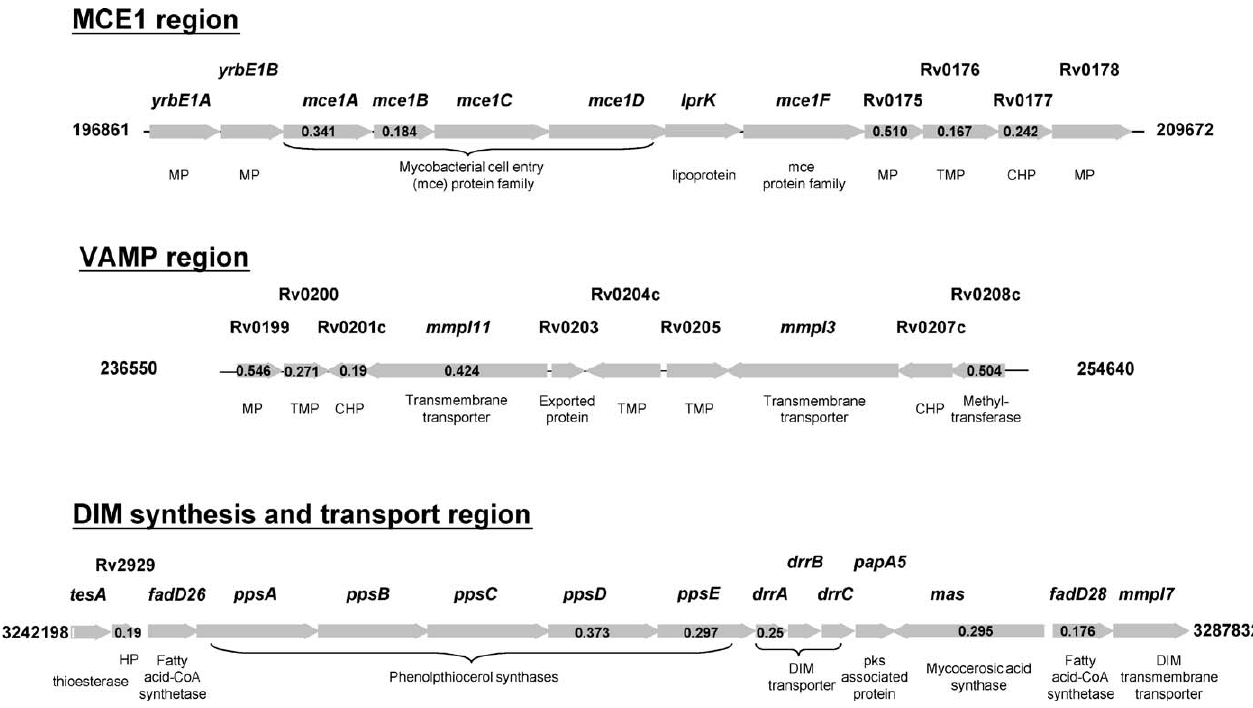
Figure 2. Gene Regions with Low Intracellular Fitness Ratios The identification of known virulence regions such as the mce1 operon and the DIM synthesis and transport region, validate the TSM intracellular fitness assay. The strategy also identified virulence regions such as VAMP . Region coordinates derived from M. tuberculosis H37Rv are shown. FRs (calculated by dividing output signal intensity by input signal intensity ) are shown inside horizontal grey arrows representing each open reading frame (open reading frames without ratios did not generate hybridisation signals). CHP, conserved hypothetical protein; HP, hypothetical protein; MP, membrane protein; TMP, transmembrane protein. DOI: